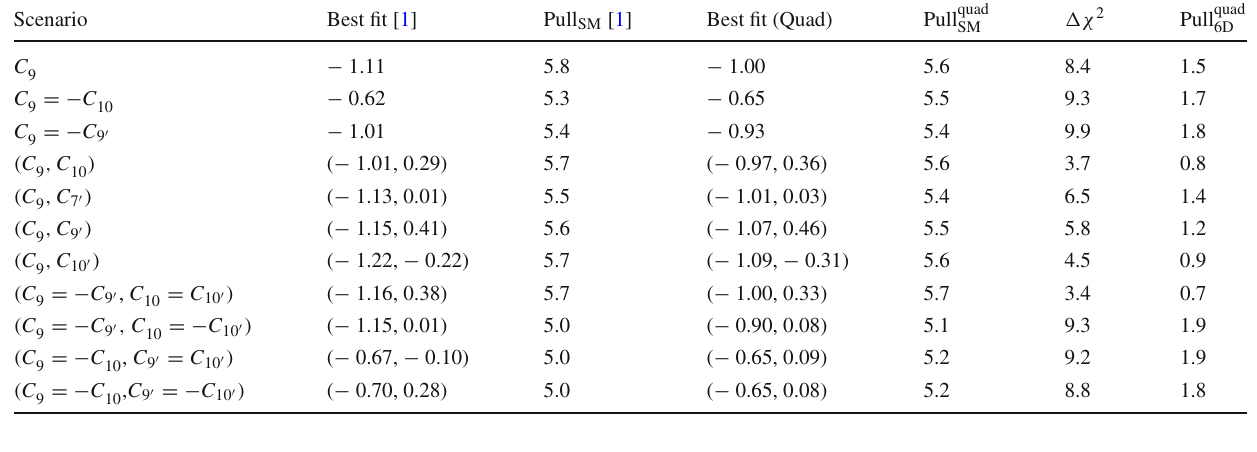
Table 1 Comparison of certain lower dimensional global χ 2 one or two parameter fits to the global six-dimensional best fit point. We also include the comparison of these scenarios to the SM as presented in